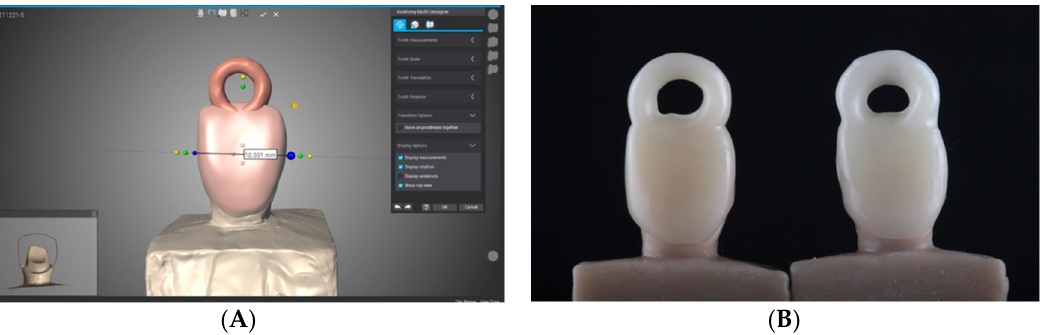
Figure 3. ( A ) STL file saved with the margin set-up and the cement space set-up. ( B ) CAD/CAM- milled temporary crowns and 3D-printed crowns on working models.